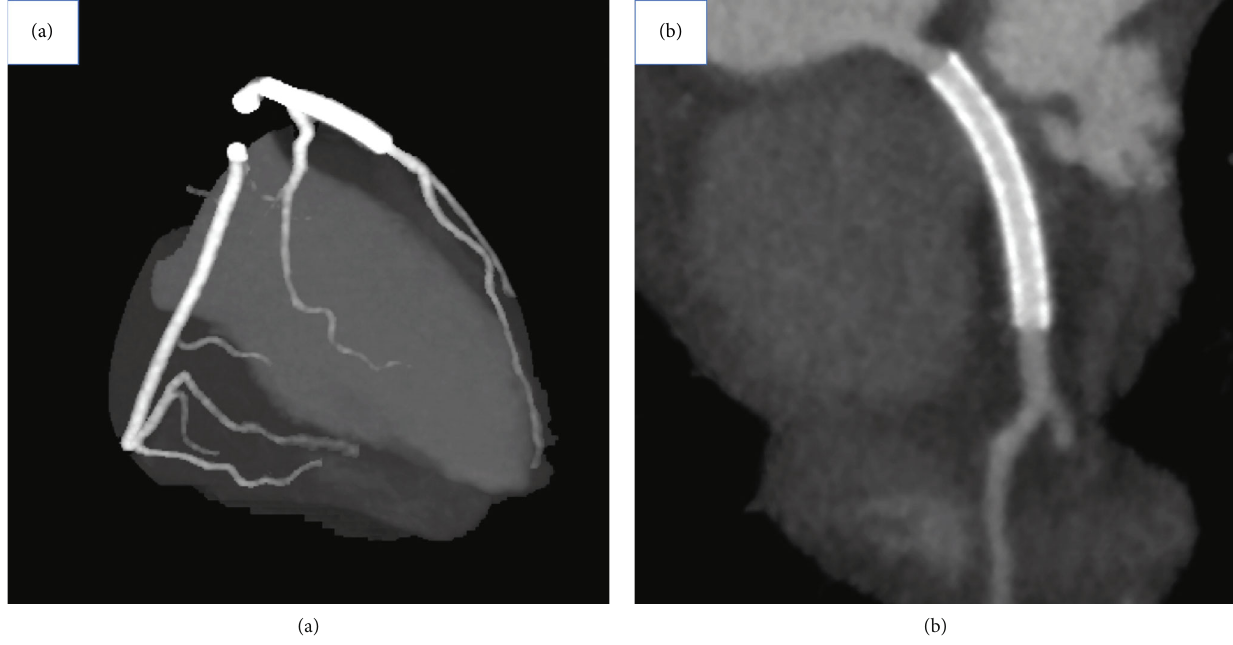
Figure 4: Coronary CT angiography performed 12 months after percutaneous coronary intervention. (a) Follow-up coronary CT angiography revealed no atherosclerotic stenosis in both the right and left coronary arteries. (b) There were no clear fi ndings of in-stent restenosis or incomplete stent apposition. CT: computed